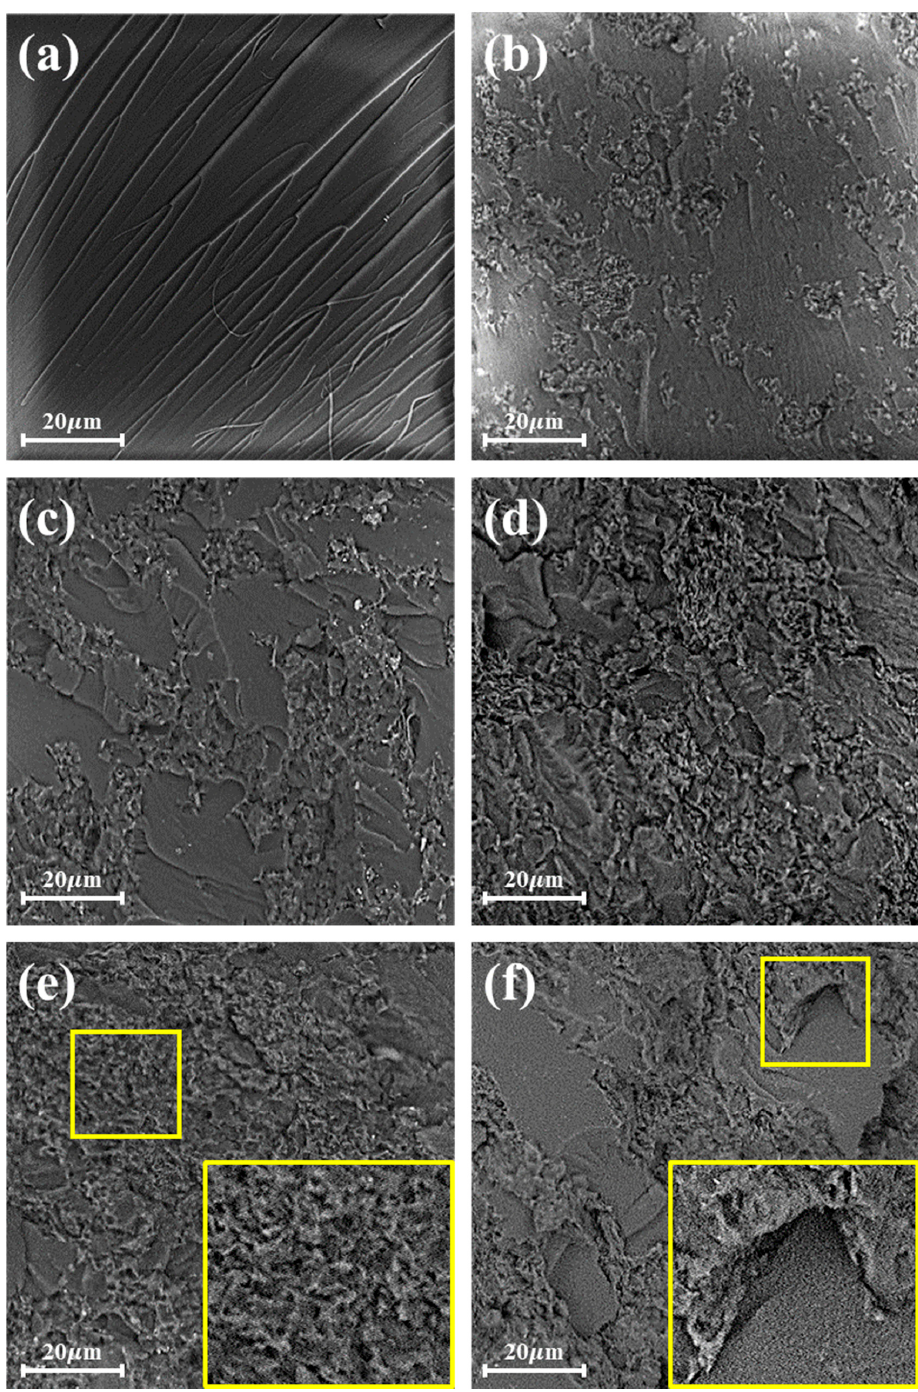
Figure 3. SEM images. ( a )Fractured surface of neat K–LCE; ( b ) fractured surface of 0.50 wt% Si–BN/K– LCE composites; ( c ) fractured surface of 1.00 wt% Si–BN/K–LCE composites; ( d ) fractured surface of Si–BN / K–LCE composites; ( c ) fractured surface of 1.00 wt% Si–BN / K–LCE composites; ( d ) fractured 2.00 wt% Si–BN/K–LCE composites; ( e ) fractured surface of 5.00 wt% Si–BN/K–LCE composites; ( f ) surface of 2.00 wt% Si–BN / K–LCE composites; ( e ) fractured surface of 5.00 wt% Si–BN / K–LCE composites; ( f ) fractured surface of 5.00 wt% raw BN / K–LCE